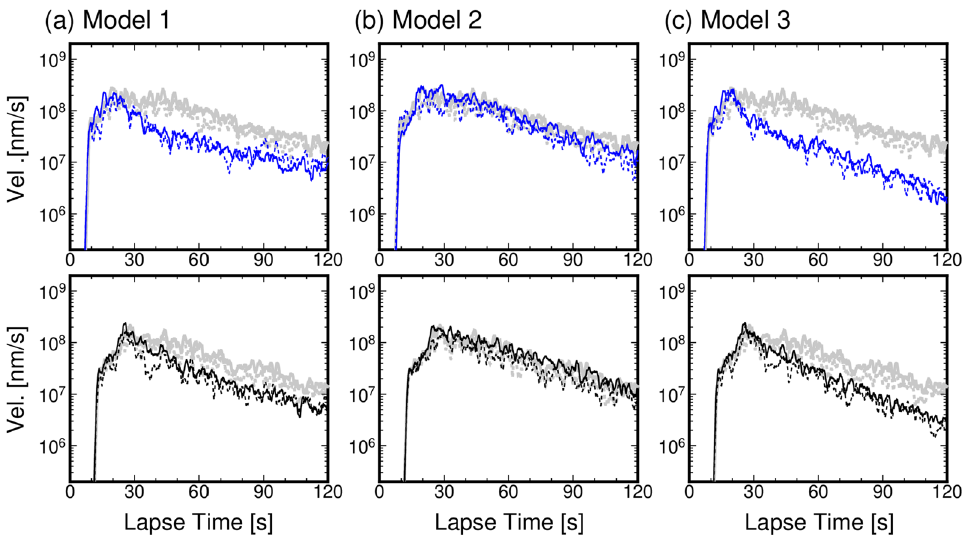
Fig. 8 Simulated envelopes of Event 1 for a Model 1, b Model 2, and c Model 3 at M.KMB06 (upper) and N.KISF (bottom). The horizontal and vertical envelopes are illustrated by solid and dotted lines, respectively. The background gray envelopes are simulation results of Model 0